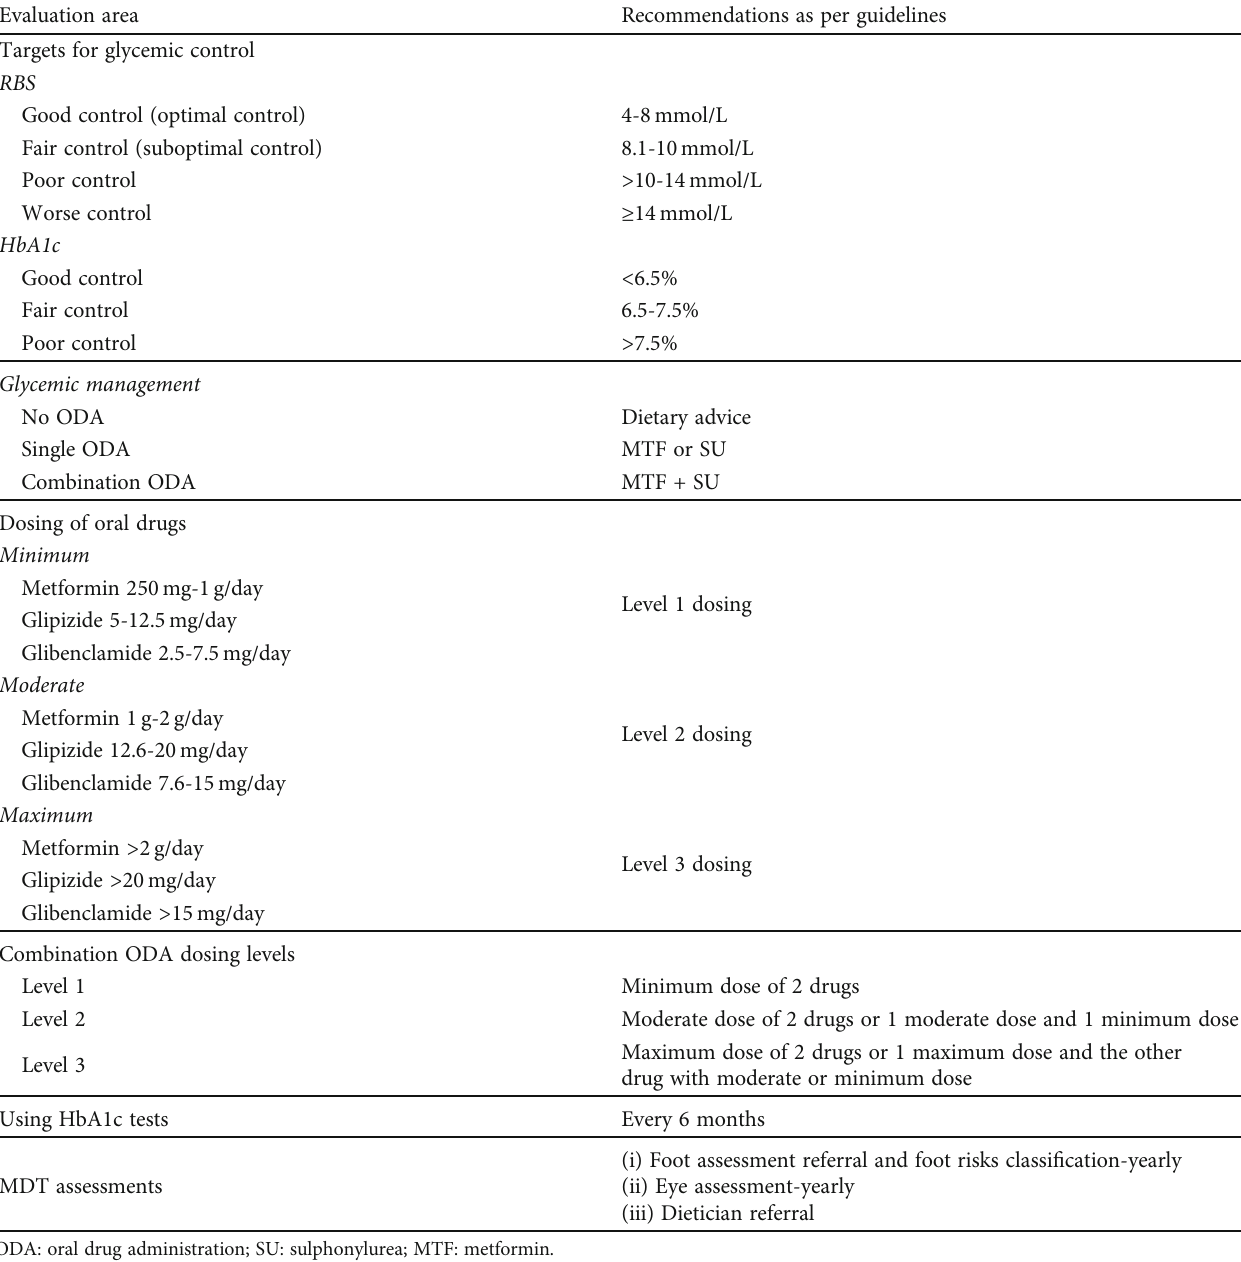
Table 1: Measures for evaluating optimal management. Description of optimal diabetic management as per the Fijian diabetes guidelines